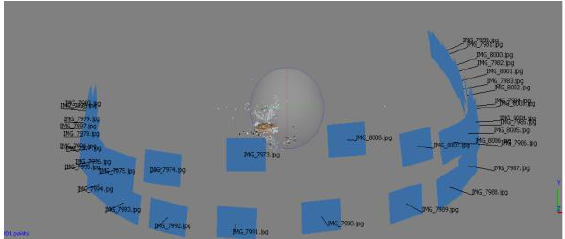
Figure 4: Incorrect alignment of the photos before the masks were used